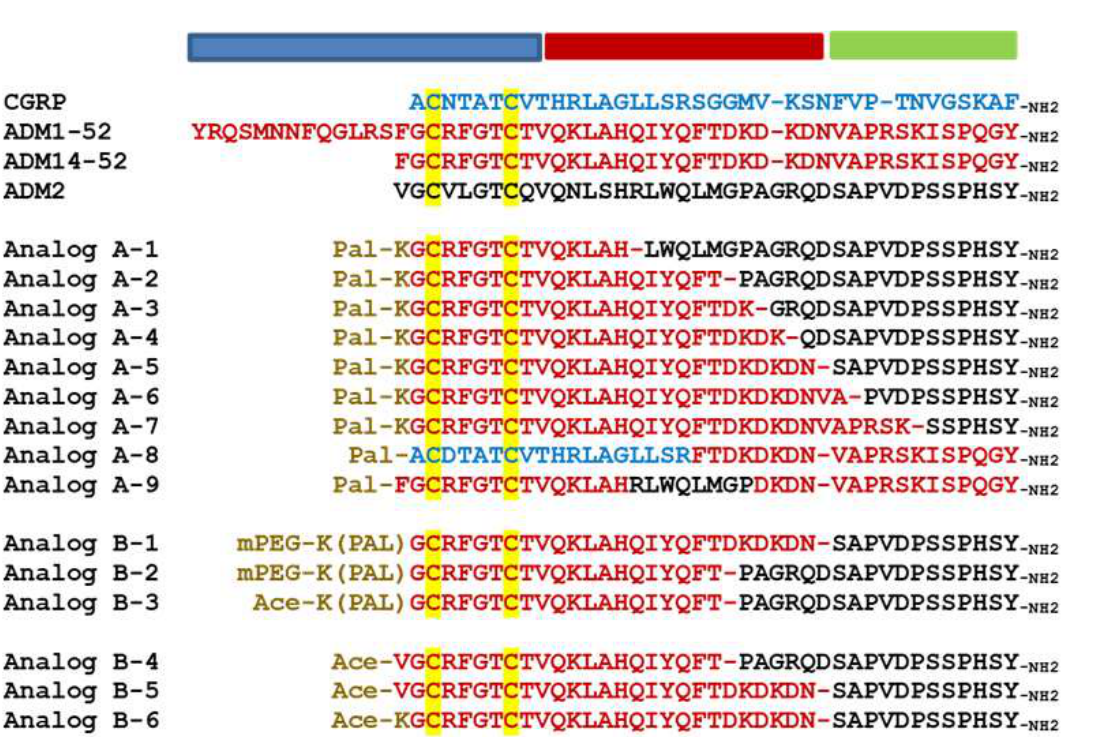
Figure 1. Alignment of ADM family peptides and chimeric analogs. The alignment includes wild- type peptides and Analogs A-1 to A9 and Analogs B-1 to B-6. In chimeric analog sequences, residues derived from CGRP, ADM, and ADM2 are indicated by blue, red, and black letters, respectively. The disulfide ring-forming cysteines are indicated by a yellow background. The N-terminal modifications, including lysine-conjugated palmitoylation (Pal-K or K(pal)) and mini-PEGylation (abbreviated as mPEG), are indicated by brown letters. Dash lines are added in select sequences to improve alignment. Acetylation is abbreviated as Ace. The putative activation, binding, and junctional regions of these peptides are indicated by blue, green, and red horizontal bars above the alignment, respectively. Table 1. EC 50 values of ADM, ADM2, CGRP, and chimeric analogs.